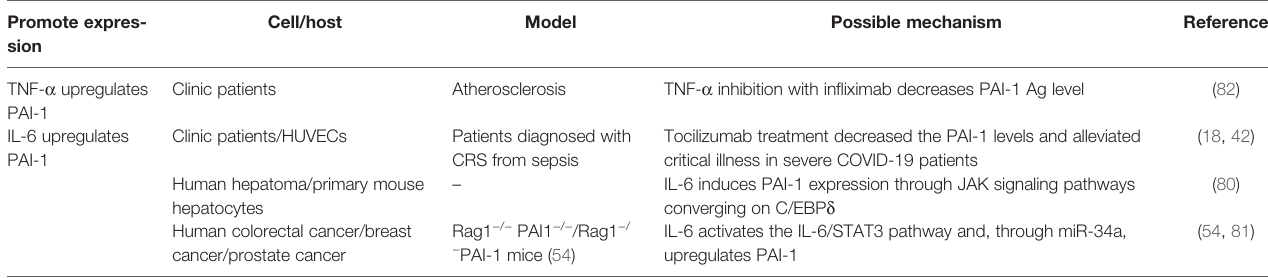
TABLE 5 | IL-6 and TNF- a promote the expression of